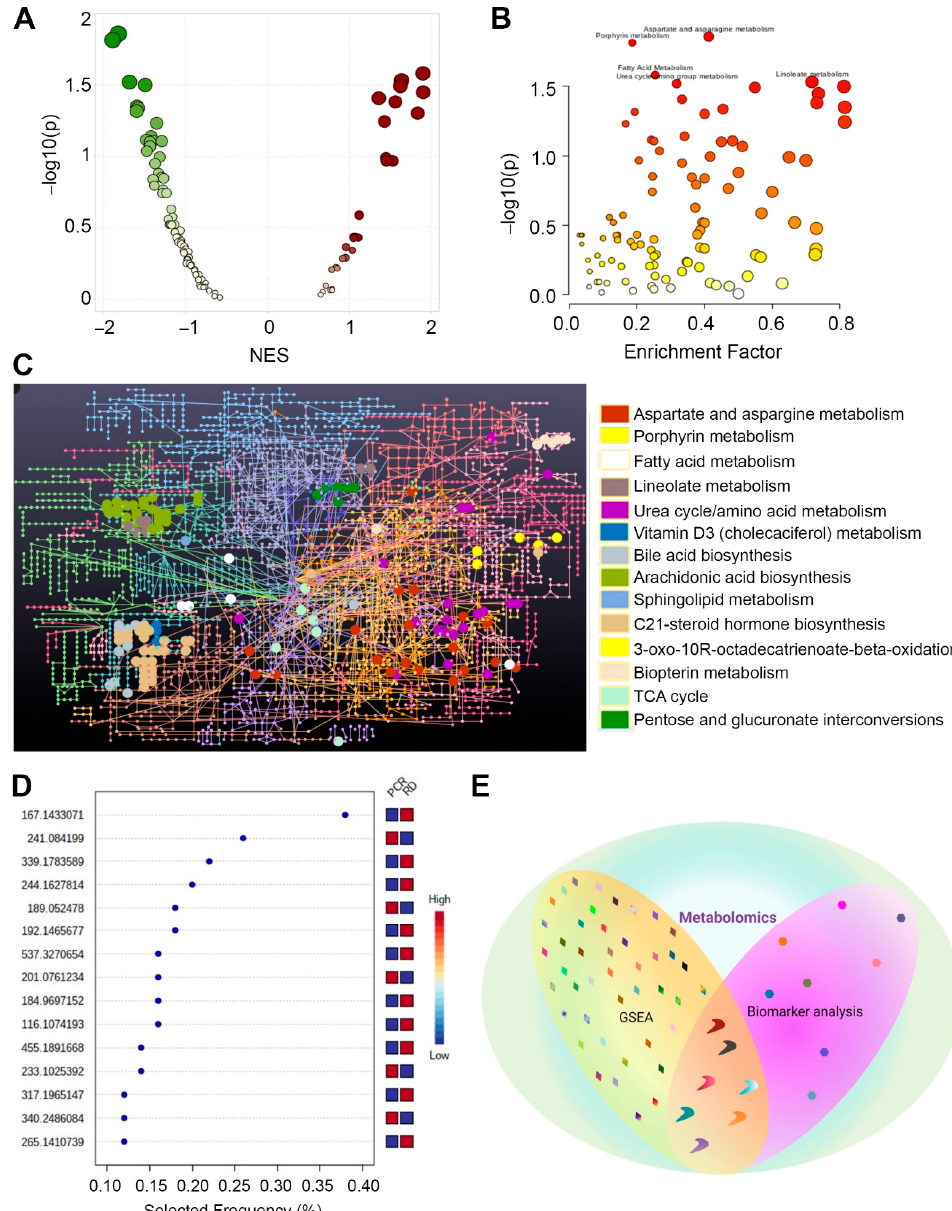
Figure 2. Differentially regulated metabolic pathways and metabolites in plasma exosomes of patients with pCR or RD after NAC. ( A ) Scatter plot showing metabolic pathways upregulated (maroon plots with positive NES) and downregulated (green plots with negative NES) in RD vs. pCR (analyzed using GSEA). The color intensity indicates the p -value, and the dot size indicates NES. ( B ) Scatter plot summarizing the pathways differentially enriched in patients with RD vs. patients with pCR after NAC; circles indicate matched pathways from user-uploaded data. The color intensity indicates the p -value, and the dot size indicates the enrichment score. ( C ) Network analysis showing metabolites in differentially regulated pathways in RD and pCR samples. Colors indicate different metabolic pathways, and circles indicate metabolites associated with a specific pathway. ( D ) Scatter plot showing the most important metabolites of a selected model ranked from most to least important (analyzed using biomarker analysis). ( E ) Venn diagram showing shared and differentially regulated metabolites identified by GSEA and biomarker analysis. Different shapes were used to differentiate the results of the two analyses. Colors are specific to metabolites that were differentially regulated in the two groups. NES, normalized enrichment score. This schematic was created using BioRender (Toronto, ON,